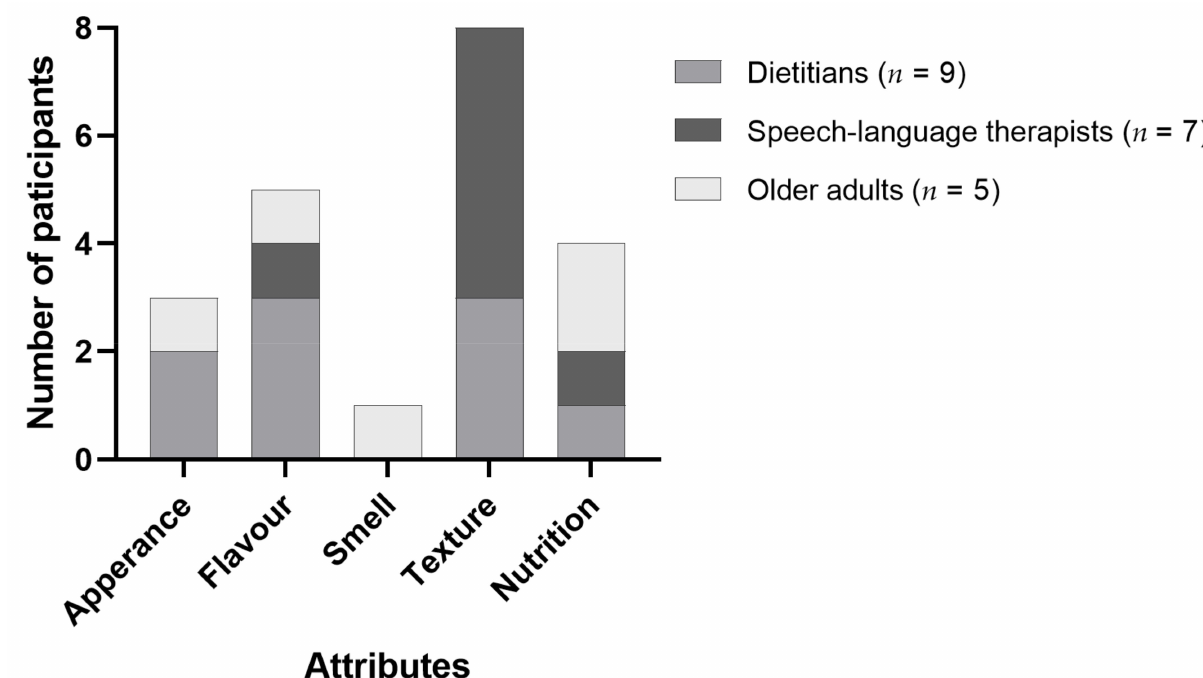
Figure 3. The most important attributes of texture-modified foods ranked by participants from focus groups ( n =